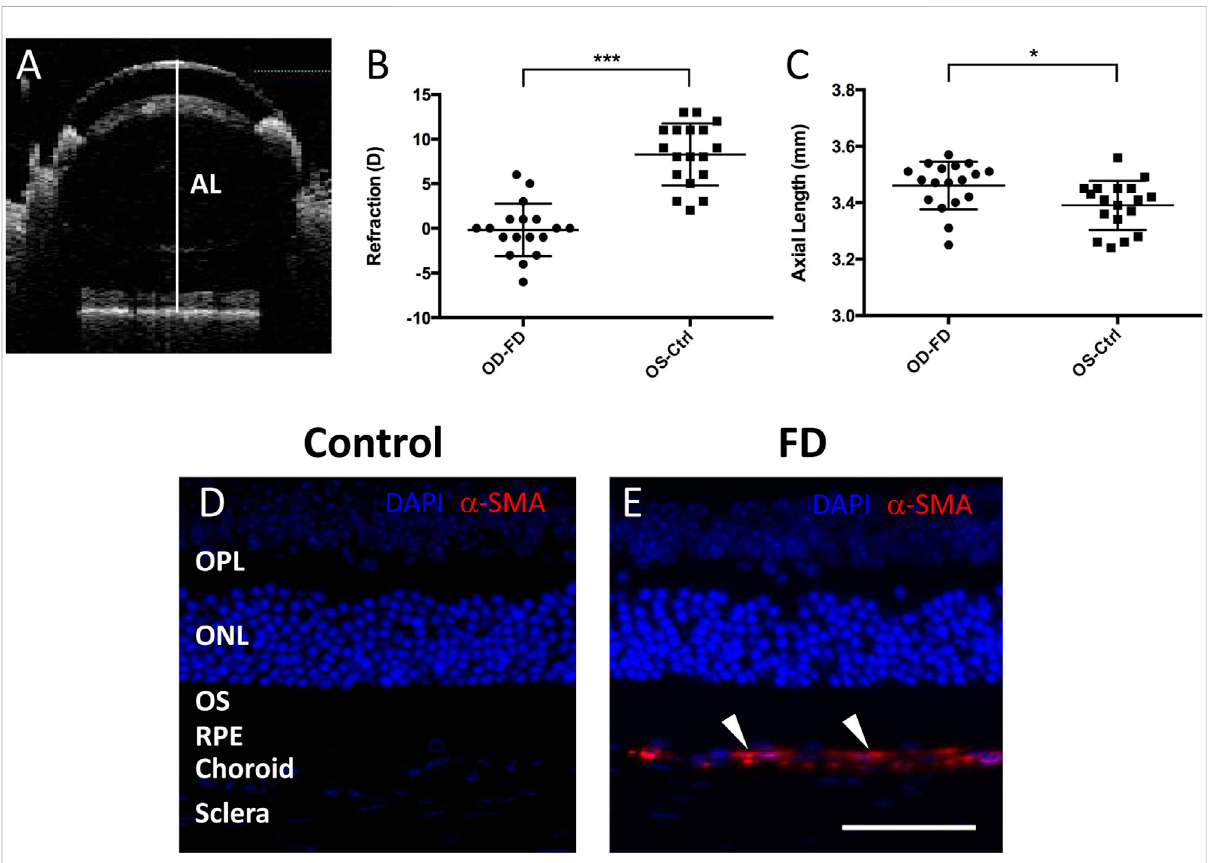
FIGURE 1 AssessmentofFDMmodelmice. (A) Representative SD-OCTimages oftheaxiallength(AL)inmice.Thewhitelineindicatestheocular AL.After 4 weeks of form deprivation, FDM eyes (OD-FD) display signi fi cant myopic refraction (B) and signi fi cant increases in AL (C) compared to fellow controls(OS-Ctrl).Immunostainingfor α -SMA( red,arrowhead )showedgreaterexpressioninthescleral andchoroidallayersofFDMmouse eyes (E) than in those of control eyes (D) on Day 28 of form deprivation induction. DAPI ( blue